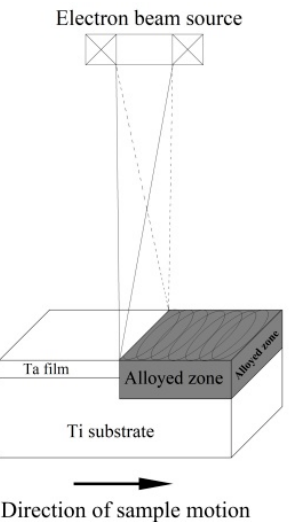
Figure 1. A scheme of electron-beam surface alloying of Ta film with Ti substrate. The structure of the obtained specimens was studied by scanning electron microscopy (SEM, LYRA I XMU (Tescan), Brno, Czech Republic). The high voltage (HV) was 20 kV. During the measurements, back-scattered electrons were used. The chemical composition was investigated by energy-dispersive X-ray spectroscopy (EDX microanalyzer—Quantax 200, Bruker, Billerica, MA, USA). The EDX detector integrates a true standardless analysis with P/B ZAF quantitative corrections (Z = the atomic number correction factor; A = X-ray absorption correction factor; F = fluorescence correction factor).